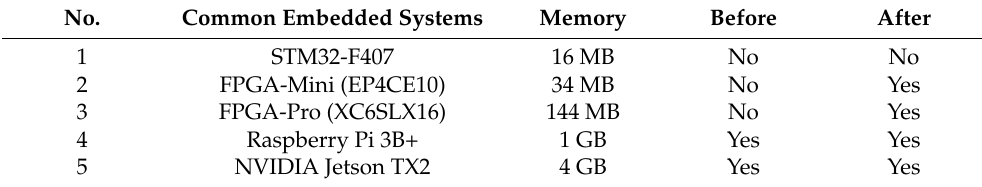
Table 1. A list of common embedded systems.